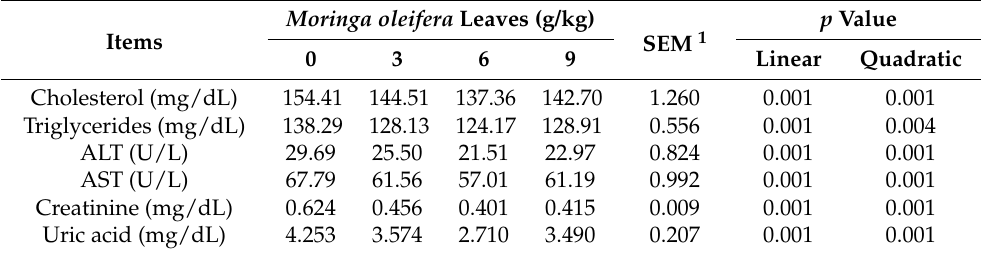
Table 5. The effect of Moringa oleifera leaves on serum metabolic profile of laying hens during the late laying period.